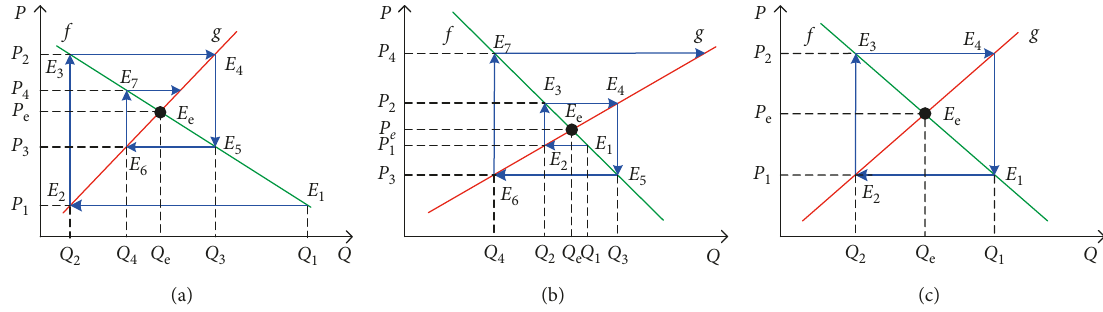
Figure 3: Dynamic modes of the cobweb model. (a) Convergent mode; (b) divergent mode; (c) closed